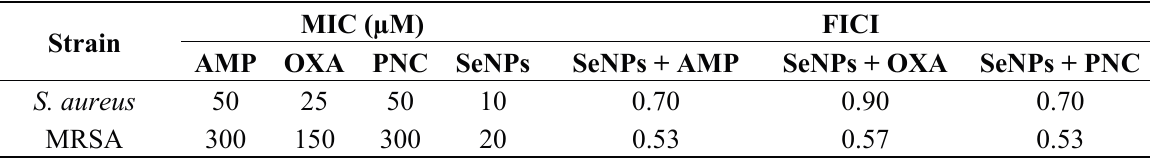
Table 2. Minimum inhibitory concentration and FICI values of SeNPs with antibiotics.